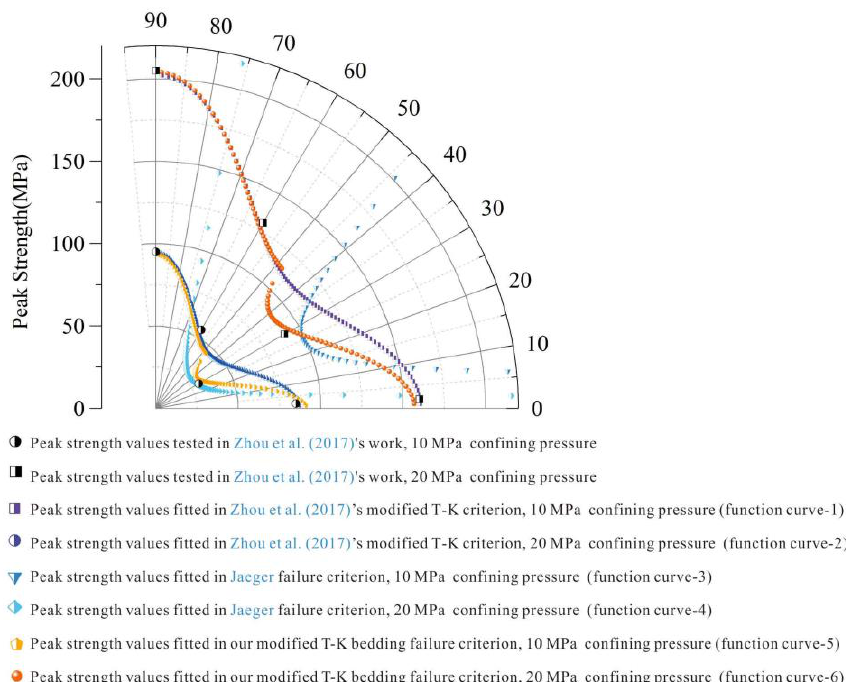
Figure 3. Function curves of the different failure criteria for the bedding fractures, i.e., the modified T–K criterion in this work, Zhou et al. (2017)’s modified T–K criterion, and the Jaeger criterion [44,47]. Black points indicate the peak strength values of the laminated rock in different confining pressures tested in Zhou et al. (2017).